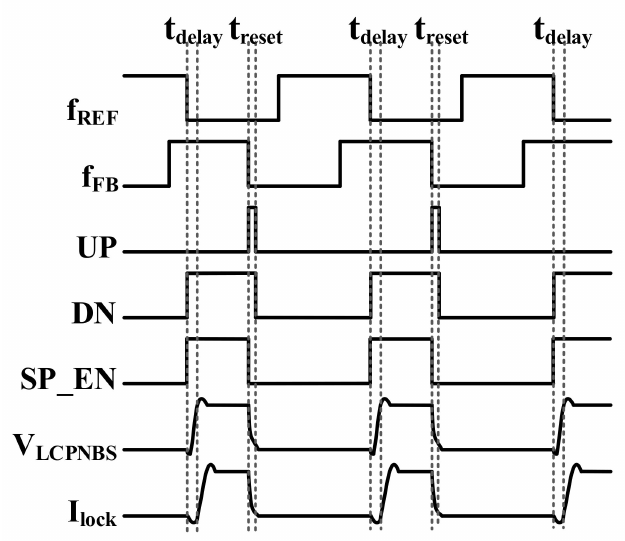
Figure 2. The fast-locking current circuit.